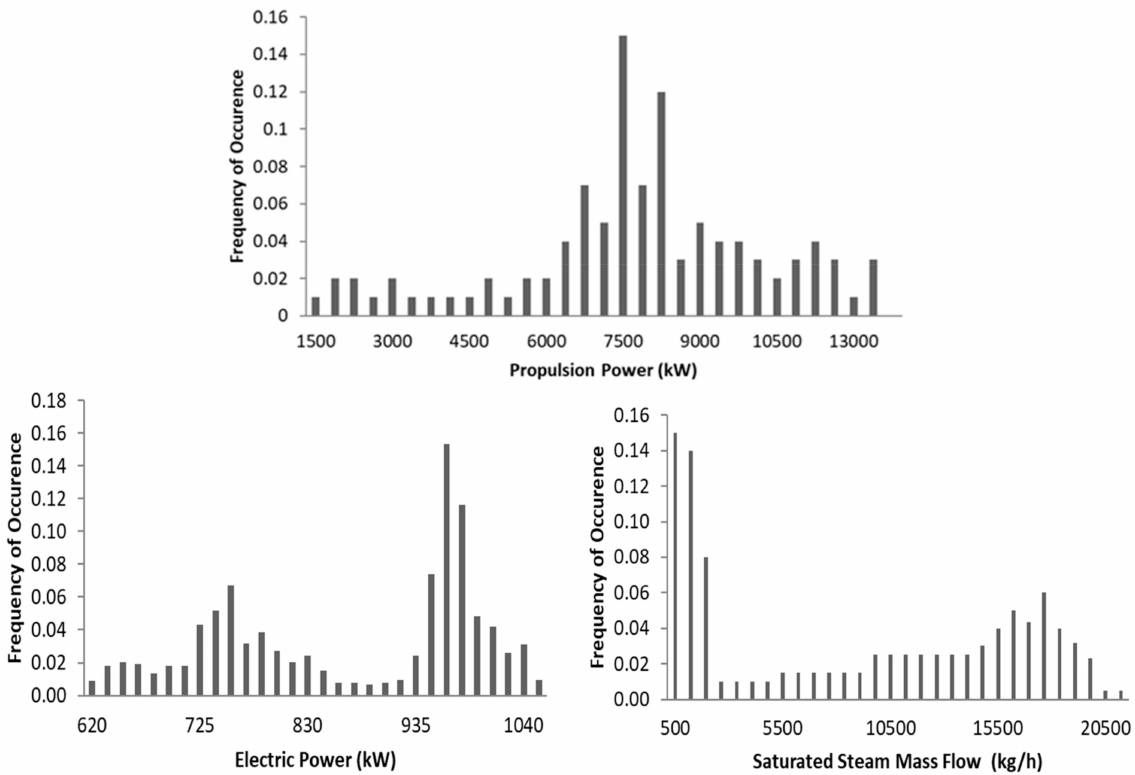
Figure 3. Typical operating profiles for an Aframax tanker adapted from [40].